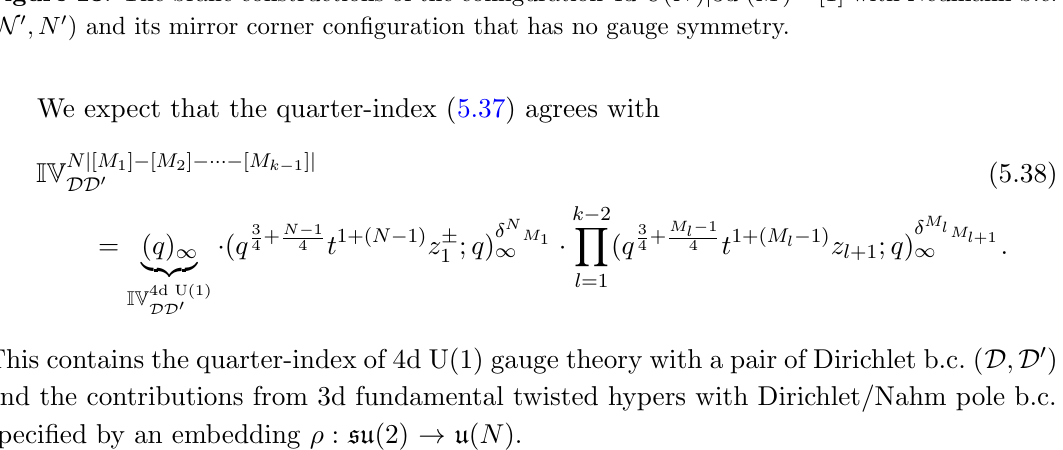
3d ( M ) [1] with Neumann b.c. | −